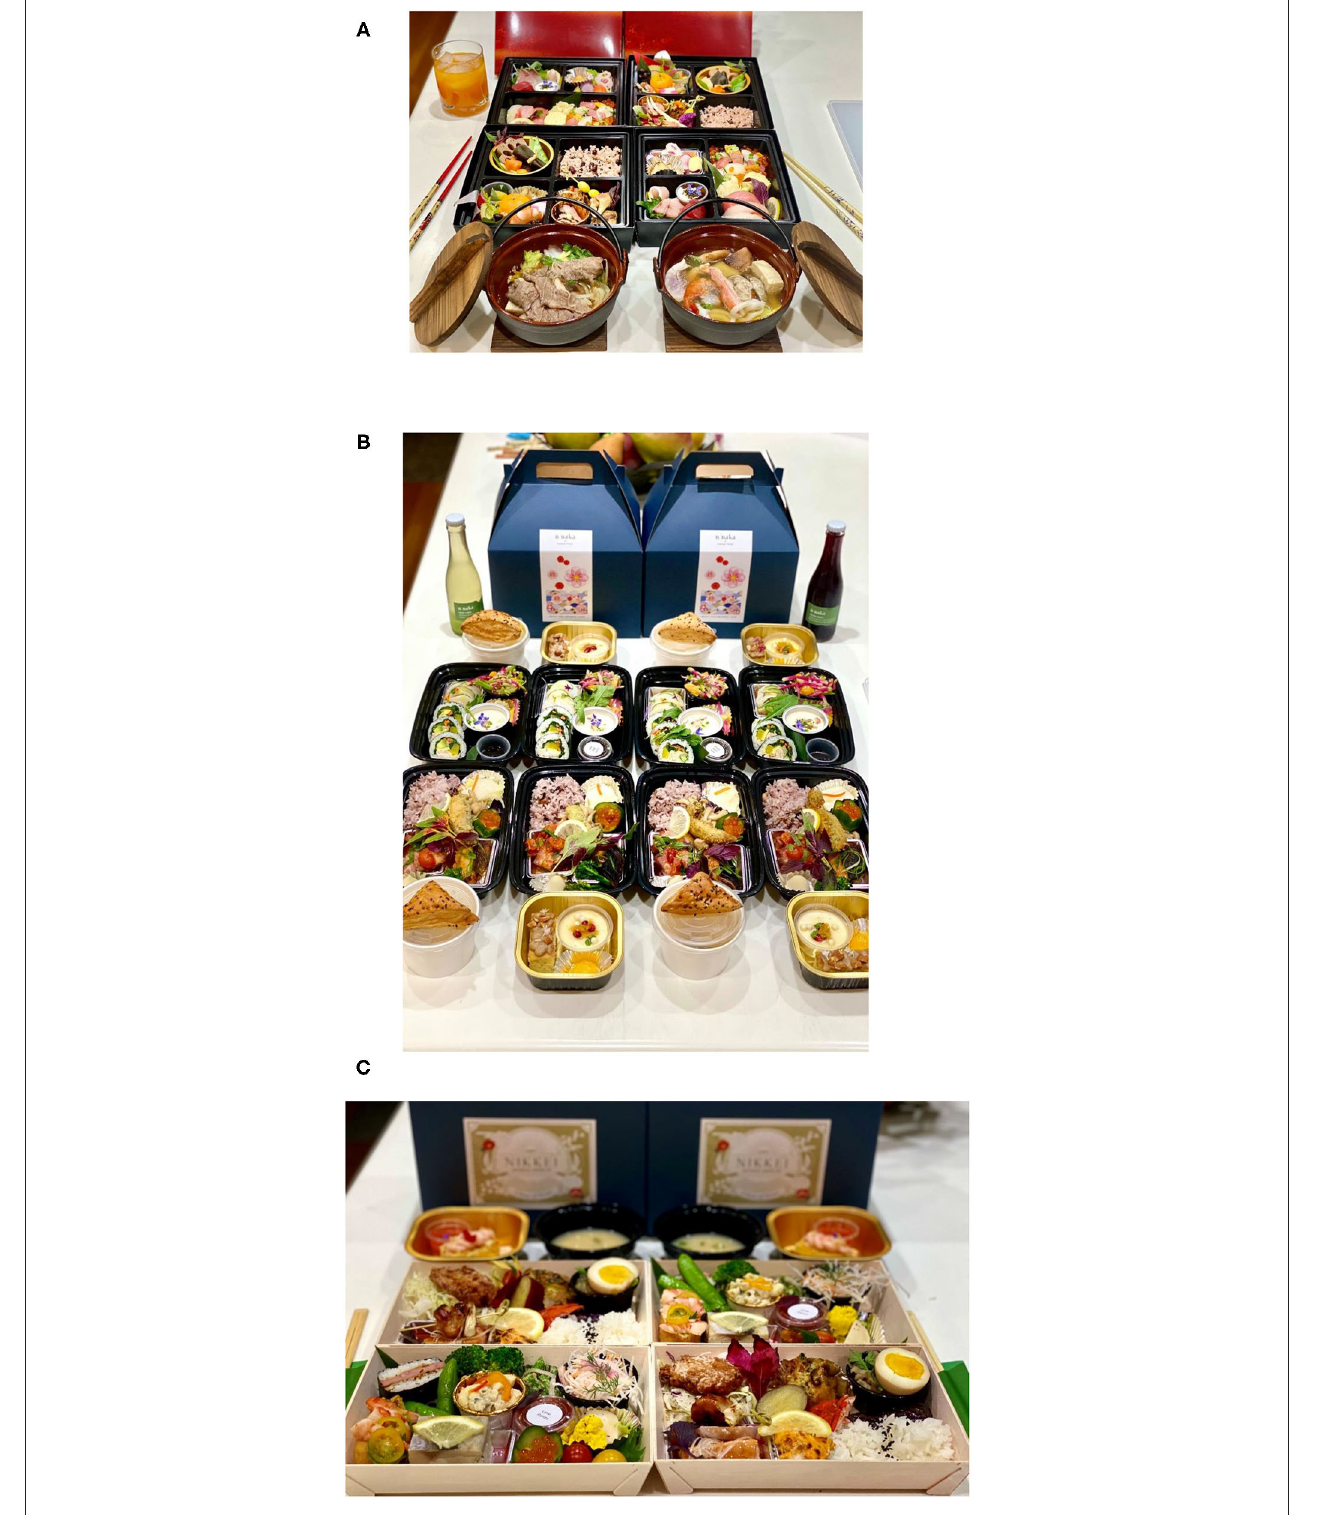
FIGURE 1 | (A) n/naka’s New Year’s Eve hot pot + bento box; (B) n/naka’s collaboration with Susan Yoon; ( C) n/soto bento box.